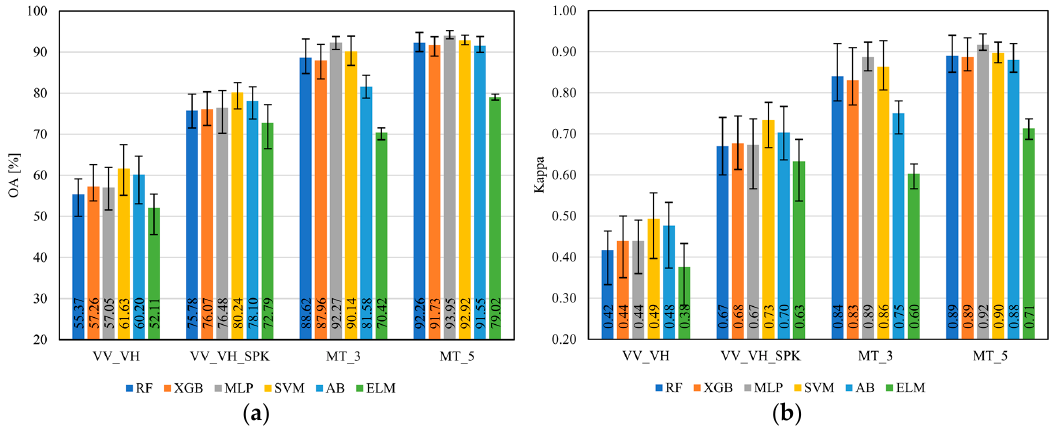
Figure 3. Mean ( a ) OA and ( b ) Kappa values obtained with various machine learning methods for different classification scenarios (error bars indicate lowest and highest classification values).